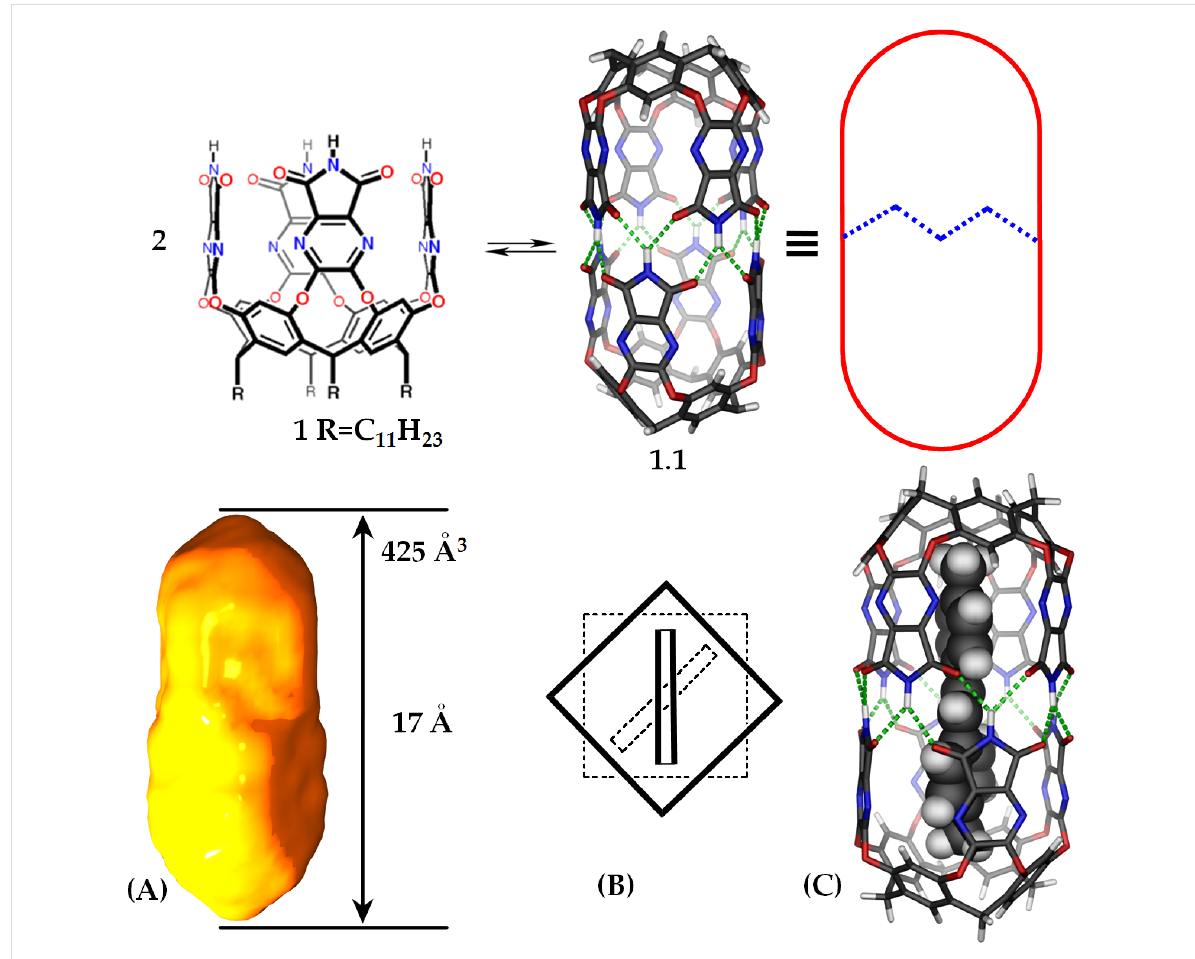
Figure 1: (Top) Tetraimide cavitand 1 , the dimeric capsule 1.1 and its cartoon representation. (Bottom) The shape of the space inside (A), a schem- atic view along the central axis with two aromatic guests (B) and an energy-minimized (AM1) complex of stilbene in 1.1